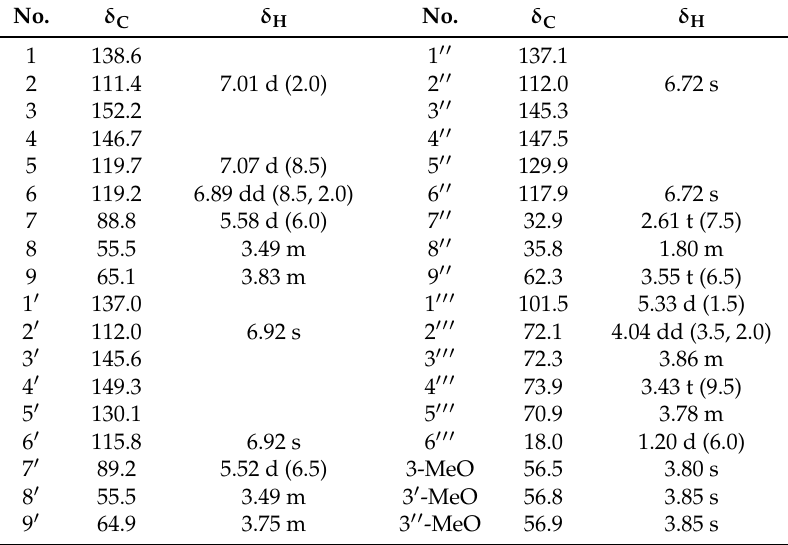
Table 1. NMR data of compound 1 (in CD 3 OD, J in